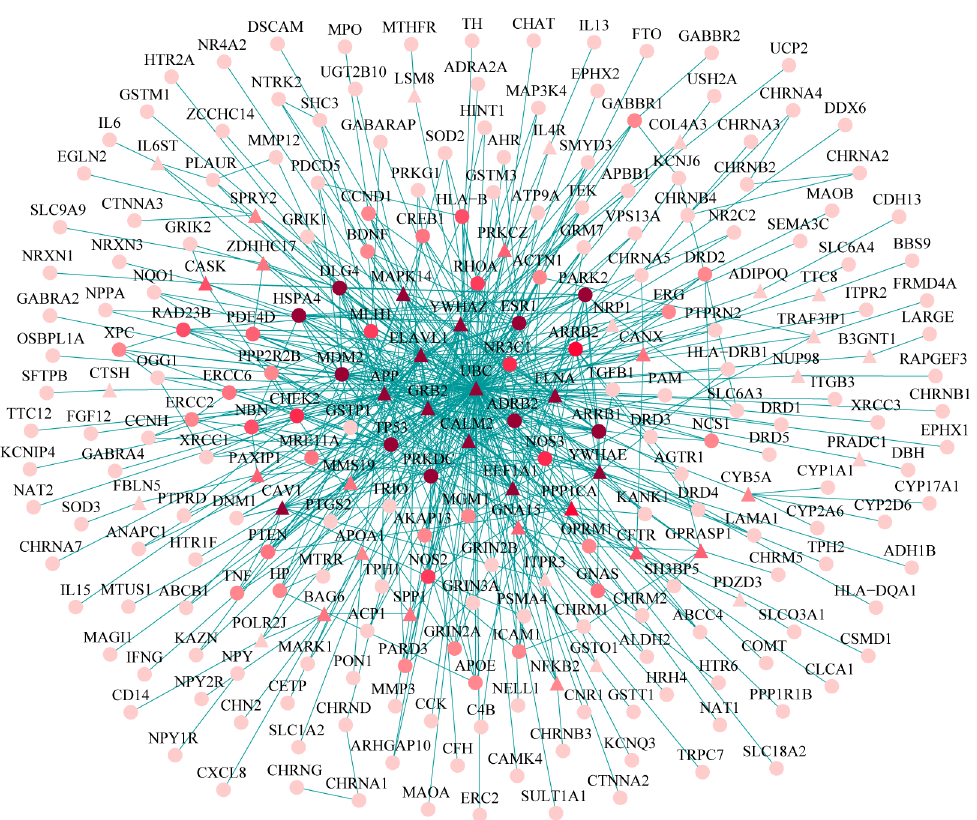
Fig 2. Nicotine addiction-specific network. Ellipse nodes are NAGenes and triangular nodes are non-NAGenes. Node color corresponds to its degree in the human PPI network. Darker color indicates higher degree.